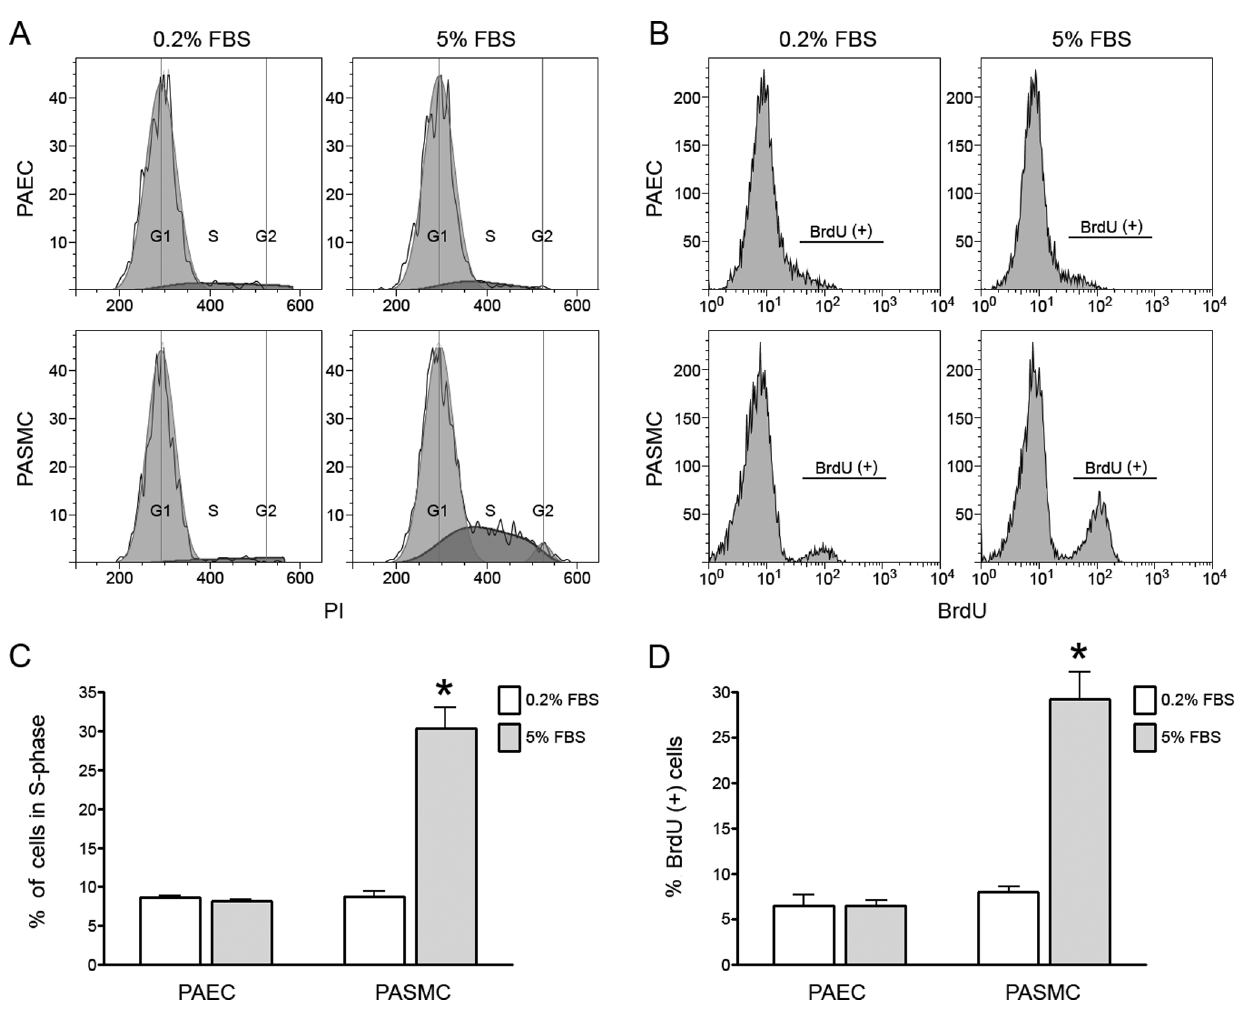
Figure 2. Increased serum stimulates cell cycle progression/DNA synthesis in confluent PASMC, but not PAEC. Human PAEC and PASMC attained confluence in low (0.2%) serum and were maintained in low serum for seven days. Cells were then exposed to 0.2% or 5% serum and cell cycle profile (A and C) and BrdU incorporation (B and D) determined 24 hours later. (n=3 experiments; * indicates p , .05).